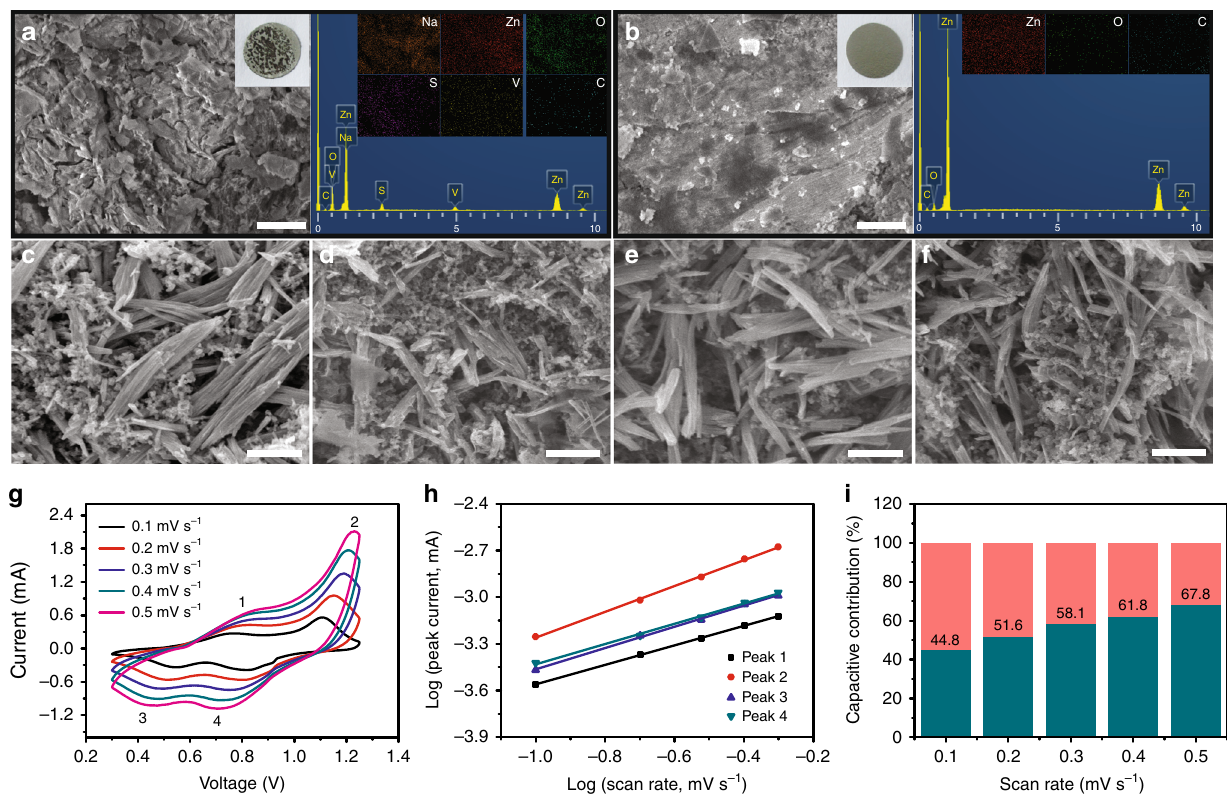
Fig. 4 Morphology change of Zn negative electrode and NVO positive electrode after cycling and kinetics of electrochemical process. SEM images and corresponding EDS analysis of Zn negative electrodes (1 A g – 1 , 100th cycle) from Zn/NVO batteries based on a ZnSO 4 and b ZnSO 4 /Na 2 SO 4 electrolytes. Scale bars, 2 μ m. SEM images of NVO electrodes at different states: c origin, d fi rst discharged to 0.3 V, e fi rst charged to 1.25 V, and f after 100 cycles at 0.1 A g – 1 in ZnSO 4 /Na 2 SO 4 electrolyte. Scale bars, 1 μ m. g CV curves of NVO electrode at different scan rates in ZnSO 4 /Na 2 SO 4 electrolyte and h the corresponding plots of log (peak current) vs. log (scan rate) at each peak. i The capacitive contributions at different scan rates in ZnSO 4 /Na 2 SO 4